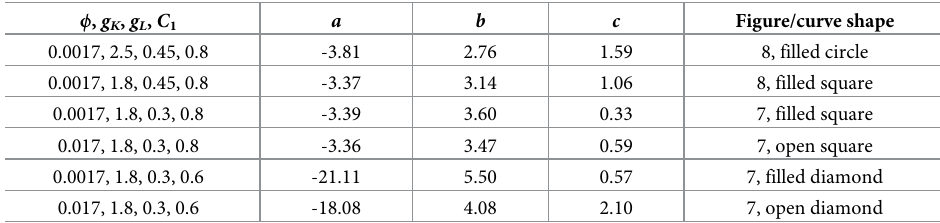
Table 2. Constants a, b, and c for curves depicted in Figs 7 and 8. The values of these constants are determined from Eq (23) using linear regression.